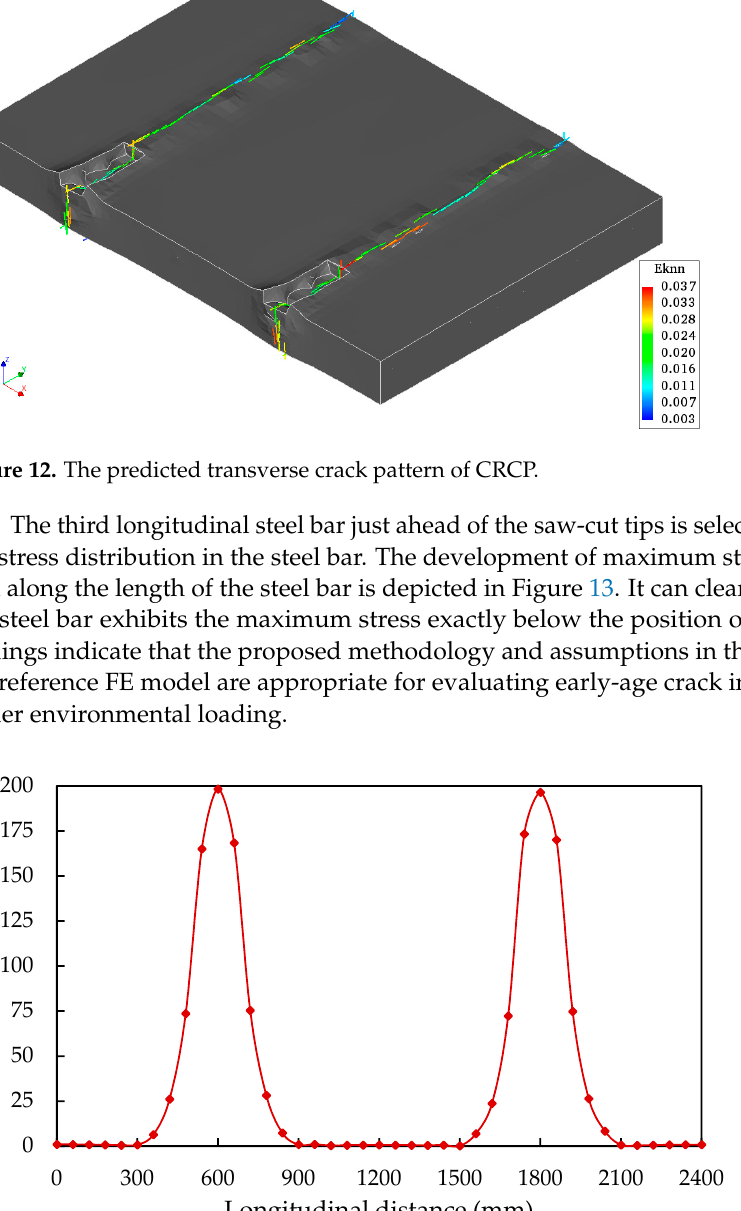
Figure 11. Crack initiation in CRCP from the saw-cuts.